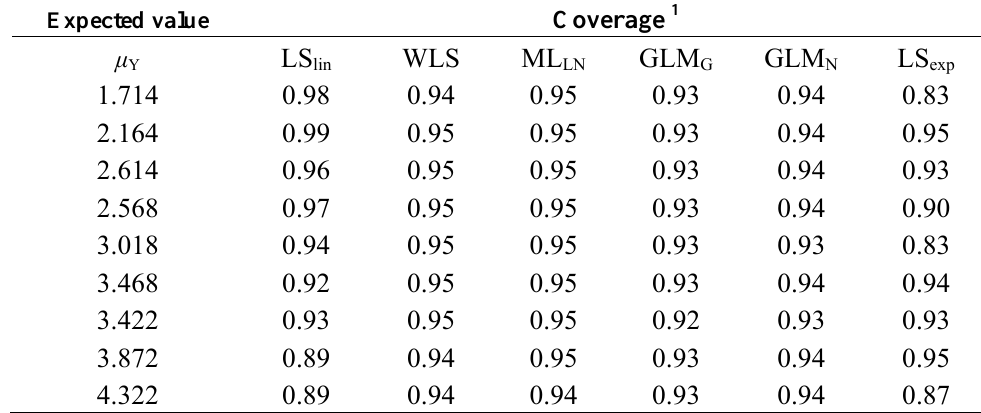
Table 4. Actual coverage of the 95% confidence interval for sample-specific standard error (results from simulation with n = 108 observations and r = 10,000 replicates).